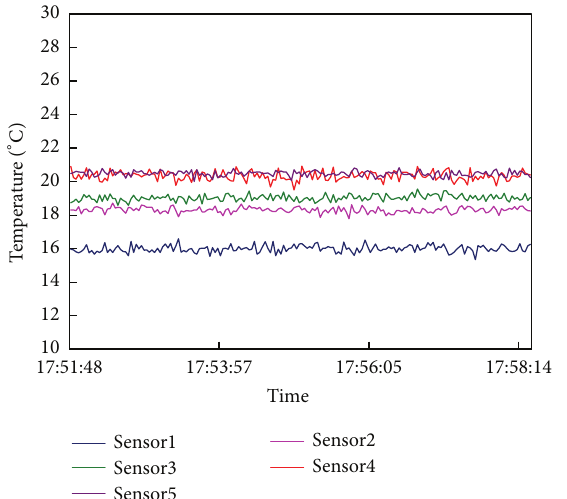
Figure 3: Duration curve of temperature sensors.